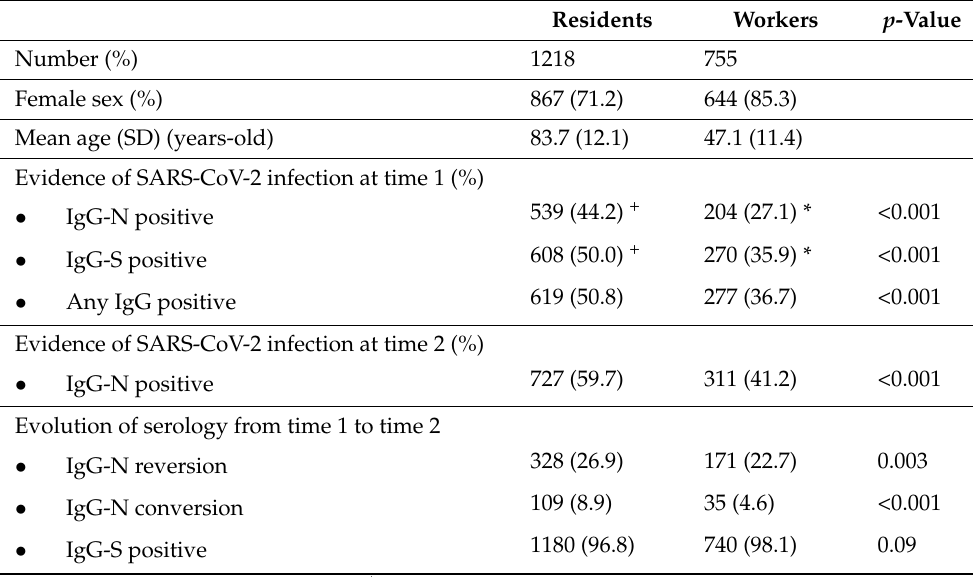
Table 1. Main characteristics of the population of study.